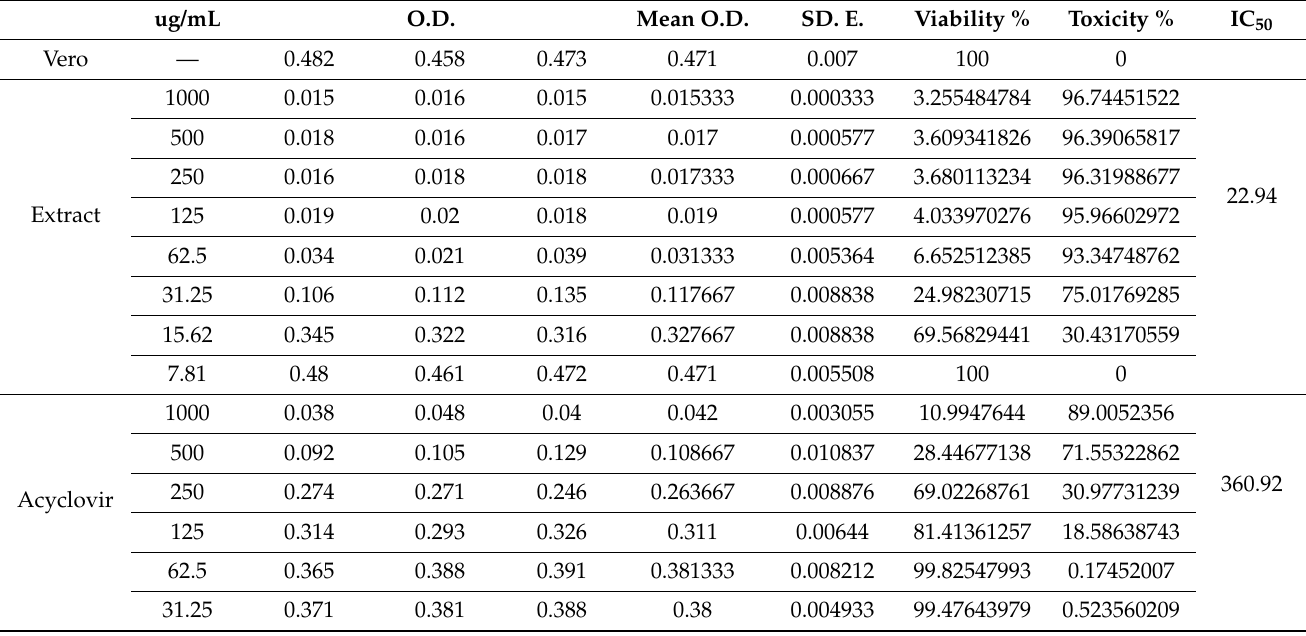
Table 3. Analyzing the cytotoxicity of the sample in Vero cells.